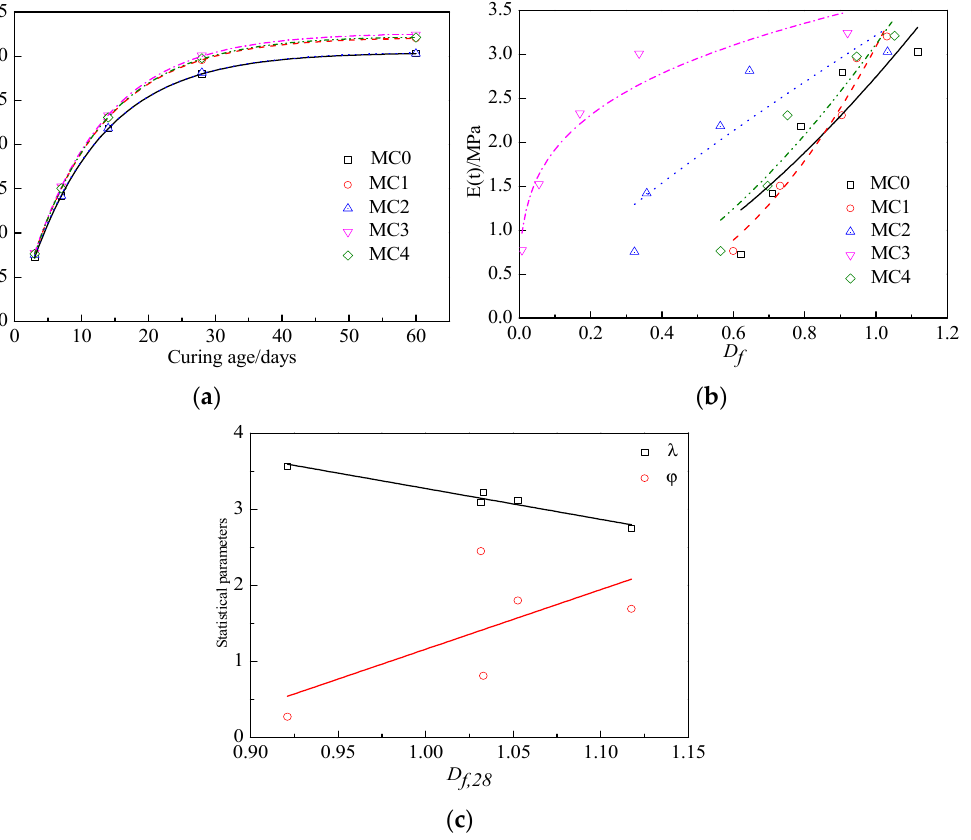
Figure 8. The relationship between modulus of elasticity and statistical parameters, curing age, and D f : ( a ) E ( t ) with age; ( b ) E ( t ) with D f ; ( c ) statistical parameters with D f ,28